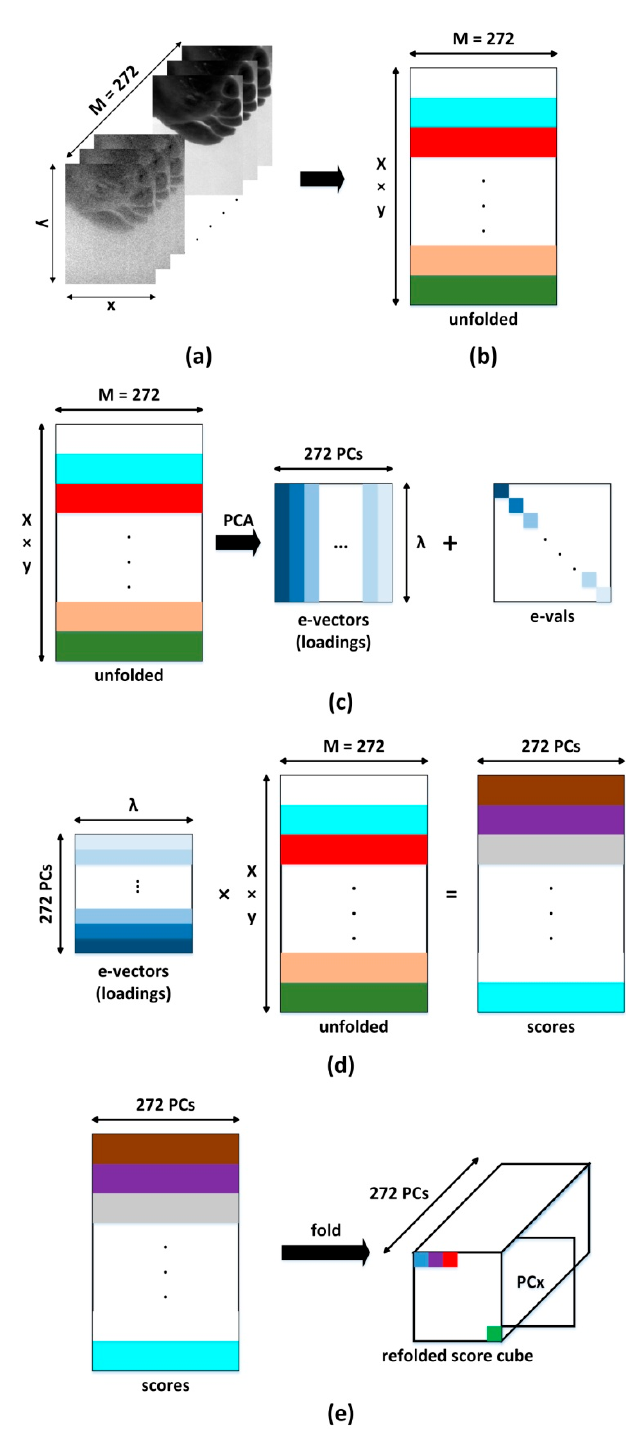
Figure 2. Principal component analysis (PCA) applied to a hypercube, where e-vector means eigenvector and e-value means eigenvalue: unfold ( a ) 3-D datacube into ( b ) 2-D matrix; ( c ) obtain eigenvectors and eigenvalues from covariance matrix; ( d ) multiply the 2-D matrix by the eigenvectors to obtain a score matrix; ( e ) refold the score matrix to form images at each principal component. PCA is dependent on the eigenvalue decomposition of the covariance matrix, and Cov (x) can be denoted in another form